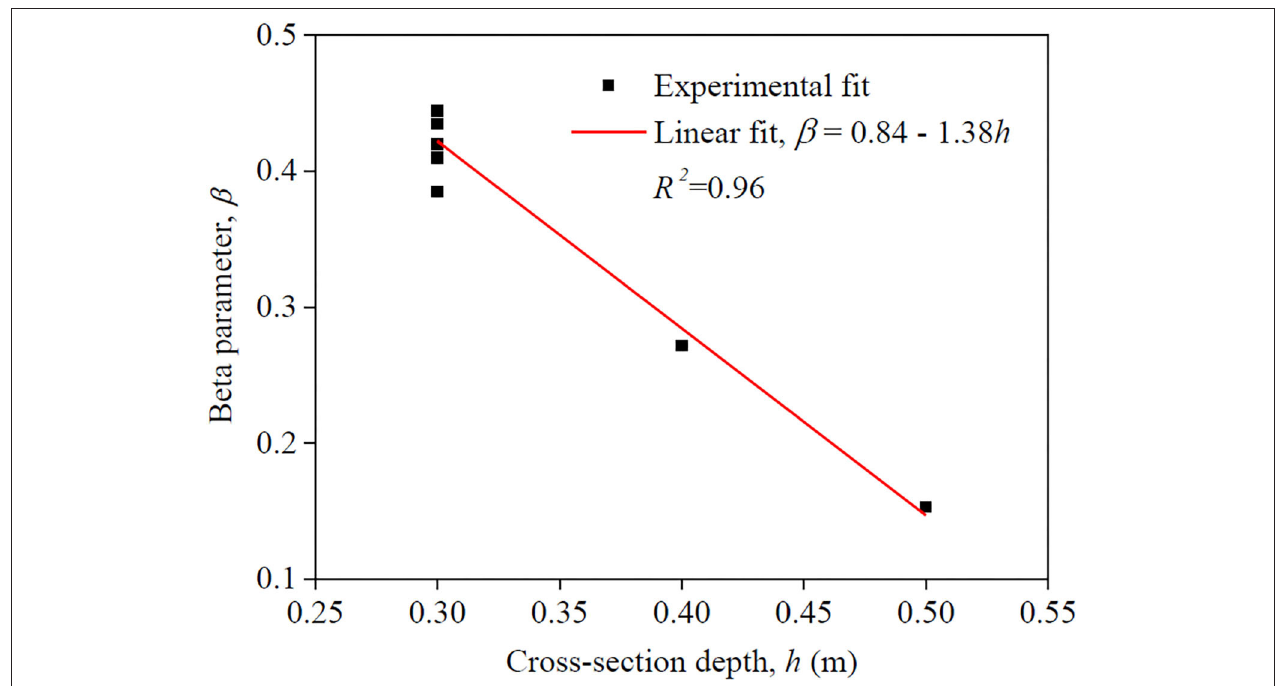
FIGURE 8 | Cross-section depth and parameter β relationship for columns with plain reinforcing bars.